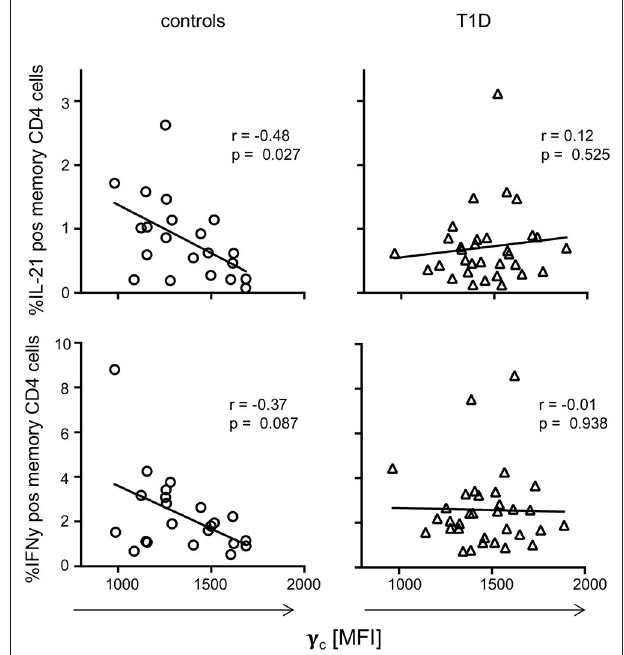
FIGURE 4 | γ c expression and cytokine production on T cell receptor stimulation. Correlation between γ c expression on CD4 + memory T-cells and in vitro activated cytokine expressing memory CD4 + T-cells (upper graphs: IL-21, bottom graphs: IFNy) are shown for healthy controls ( n = 21, left graphs) and patients with T1D ( n = 33, right graphs). Spearman rank correlation coefficients ( r ) and respective p -values are indicated. A trend line was fitted by linear regression